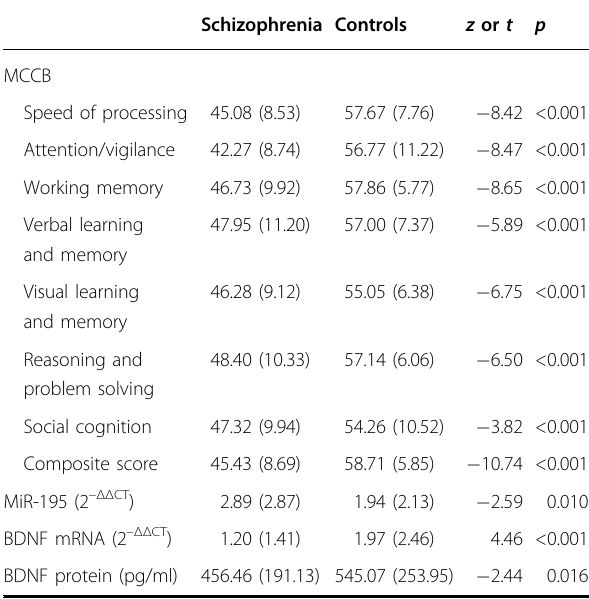
Table 2 MCCB scores, miRNA levels, BDNF mRNA, and protein expression levels.